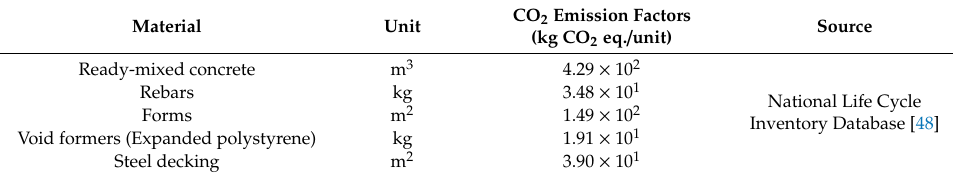
Table 1. Carbon dioxide emissions factors of building materials.